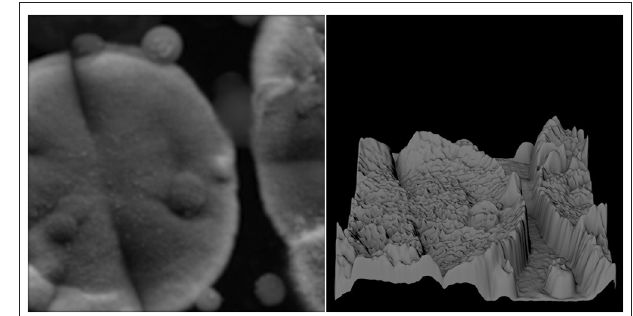
FIGURE 5 | Grayscale 512 × 512-pixel section of a microbial scan (Left) . Shape of corresponding terrain when directly mapping grayscale values to height, including sudden peaks at spatial locations with high luminance (Right) .